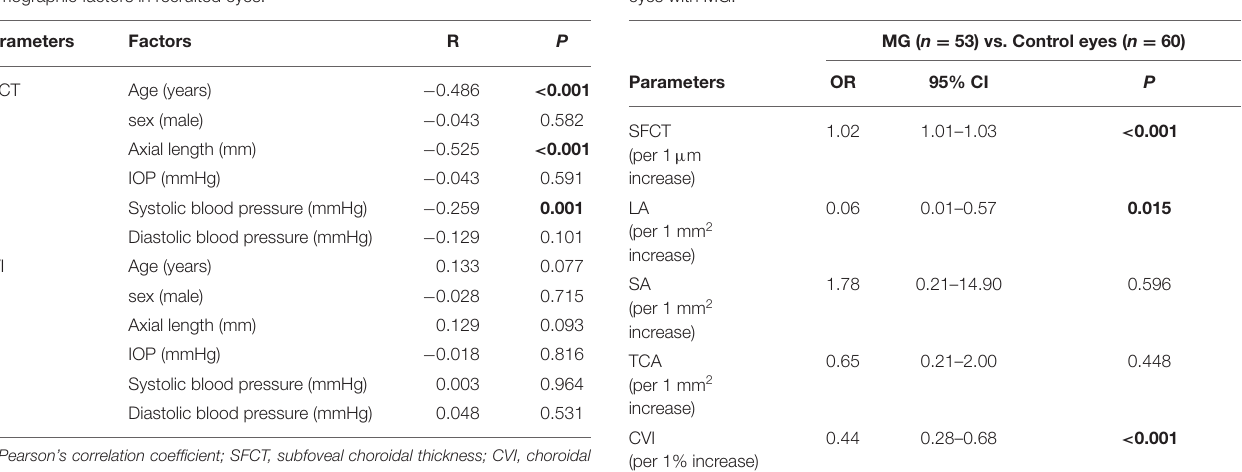
TABLE 3 | The multiple logistic regression analysis of the associated factors for eyes with